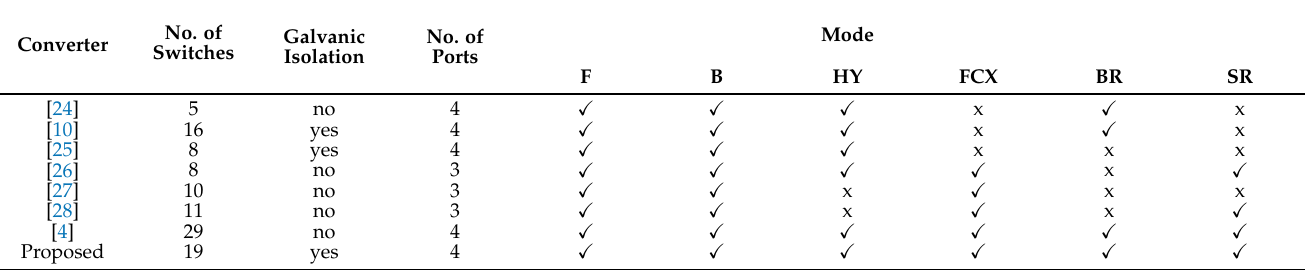
Table 10. Features comparison of multi–port converters with the proposed